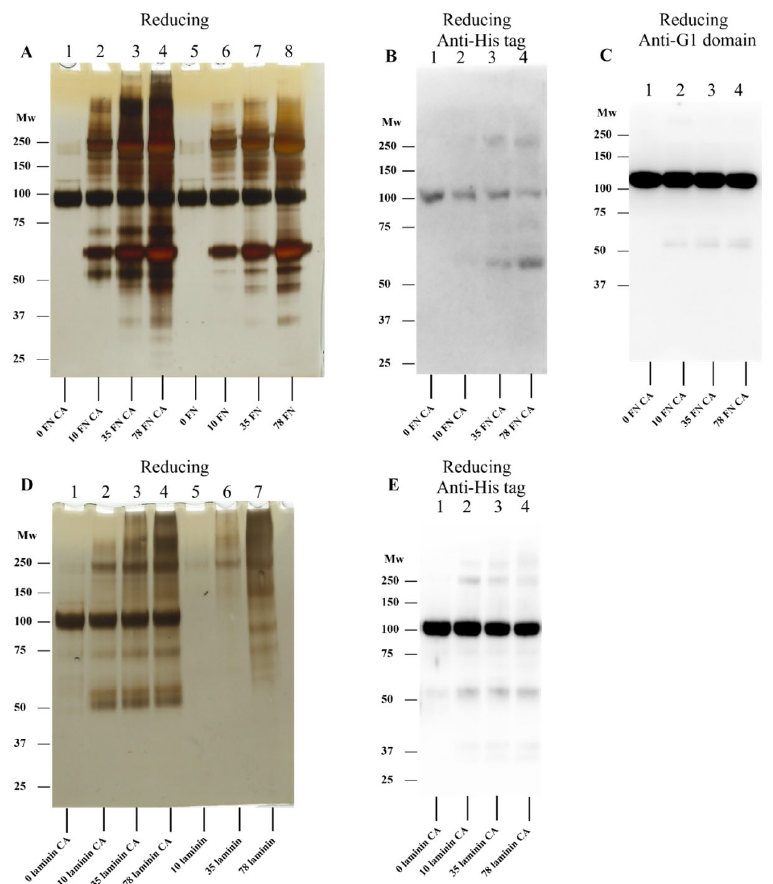
Figure 9. Effects of human plasma fibronectin (FN-CA) and laminin (laminin-CA) chloramines on rhAggrecan. Defined molar excesses of preformed chloramines (as indicated; bars labelled FN CA and laminin-CA), together with identical concentrations of the proteins treated with PBS in place of HOCl (lanes marked FN control and laminin control), were incubated with rhAggrecan (643 nM) for 24 h at 37 °C in buffer A. The samples were then subjected to gel electrophoresis under reducing conditions (panel A–C for FN, panels D,E for laminin, respectively) and Western blotting by using the anti-His-tag antibody (panels B , D,E ) and anti-G1 domain (panel C ) as described in Section 2 and the legend to Figure 3. Molecular mass markers are indicated on the left of each image. Images are representative data from three independent experiments.